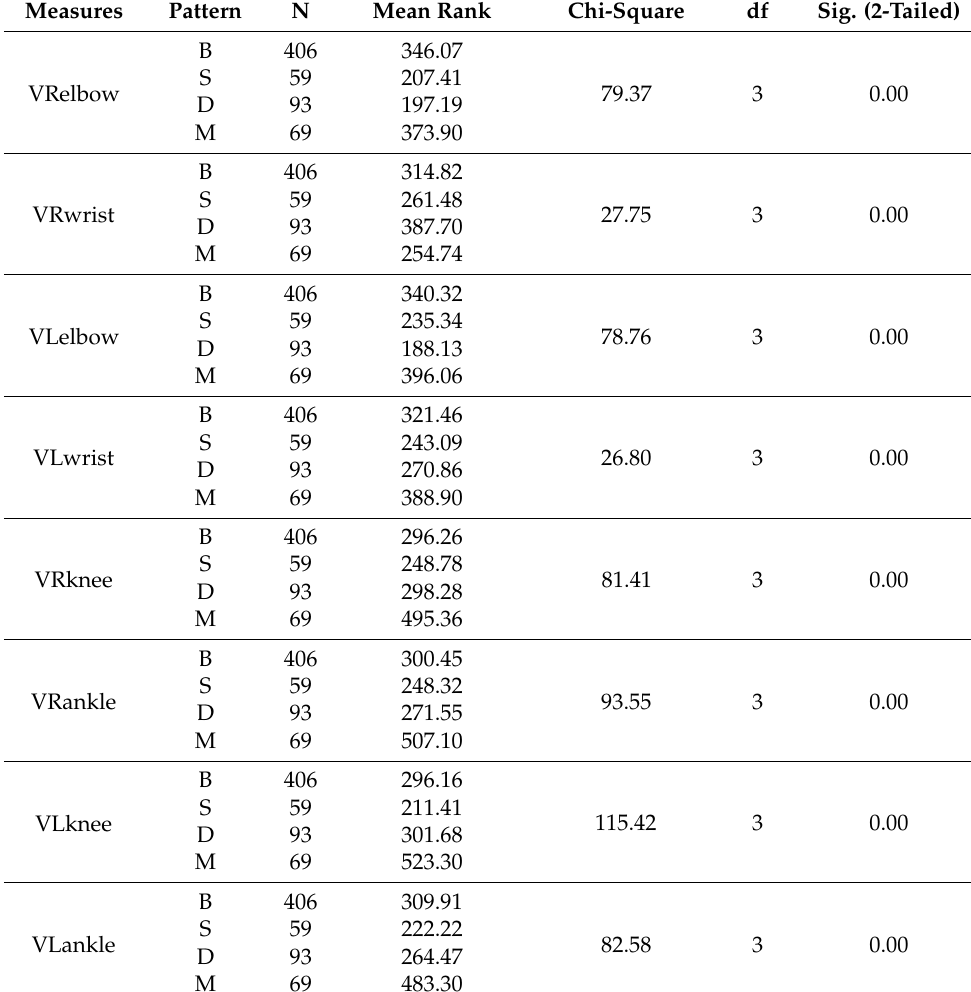
Table 6. Results of Kruskal–Wallis one-way